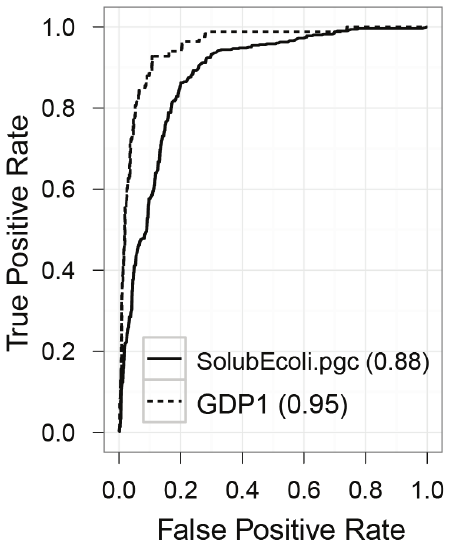
Figure 2. Receiver operating characteristic (ROC) curves. ROC curves of the soluble protein classifier (SolubEcoli.pgc) and the GroEL obligate protein classifier (GDP1.pgc). The areas under the curves (AUC) are given in the Table 1. Comparison of previous classifiers with our classifier.